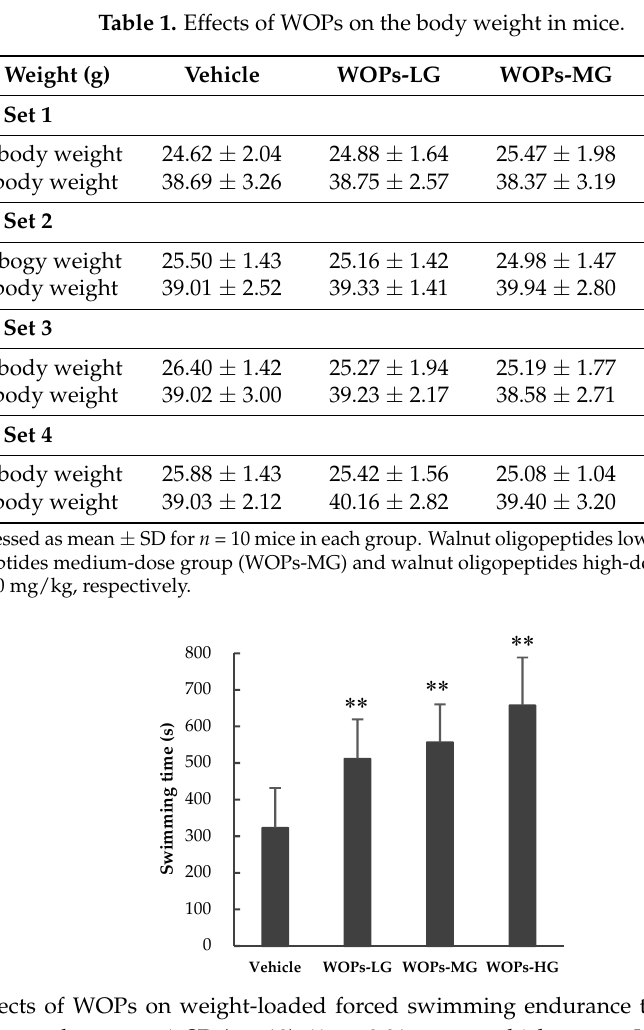
Figure 1. Effects of WOPs on weight-loaded forced swimming endurance time in mice. All the values are presented as mean ± SD ( n = 10), ** p < 0.01 versus vehicle group. WOPs-LG, WOPs-MG, WOPs-HG refer to that mice were treated with walnut oligopeptides (WOPs) at 110, 220 and 440 mg/kg for 30 days, respectively.